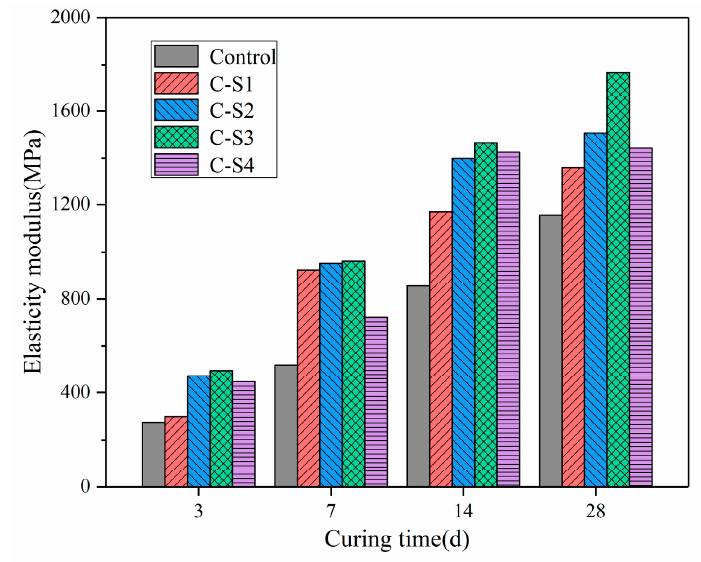
Figure 7. The EM of PCCPB with different Na 2 SO 4 dosages. Figure 8 reflects the variation of the EM of PCCPB with UCS, which shows that as the UCS increases, the EM increases, and vice versa. The relationship between UCS and